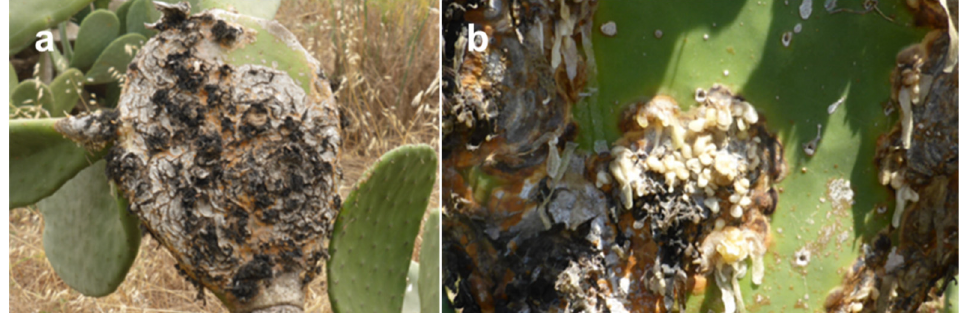
Figure 1. Symptoms of scabby cankers on cladodes of pear cactus ( O. ficus-indica L.), including concentric, perennial cankers with carbonaceous appearance ( a panel), and a viscous exudate, caking on contact with air, which leaked from cankers ( b panel).